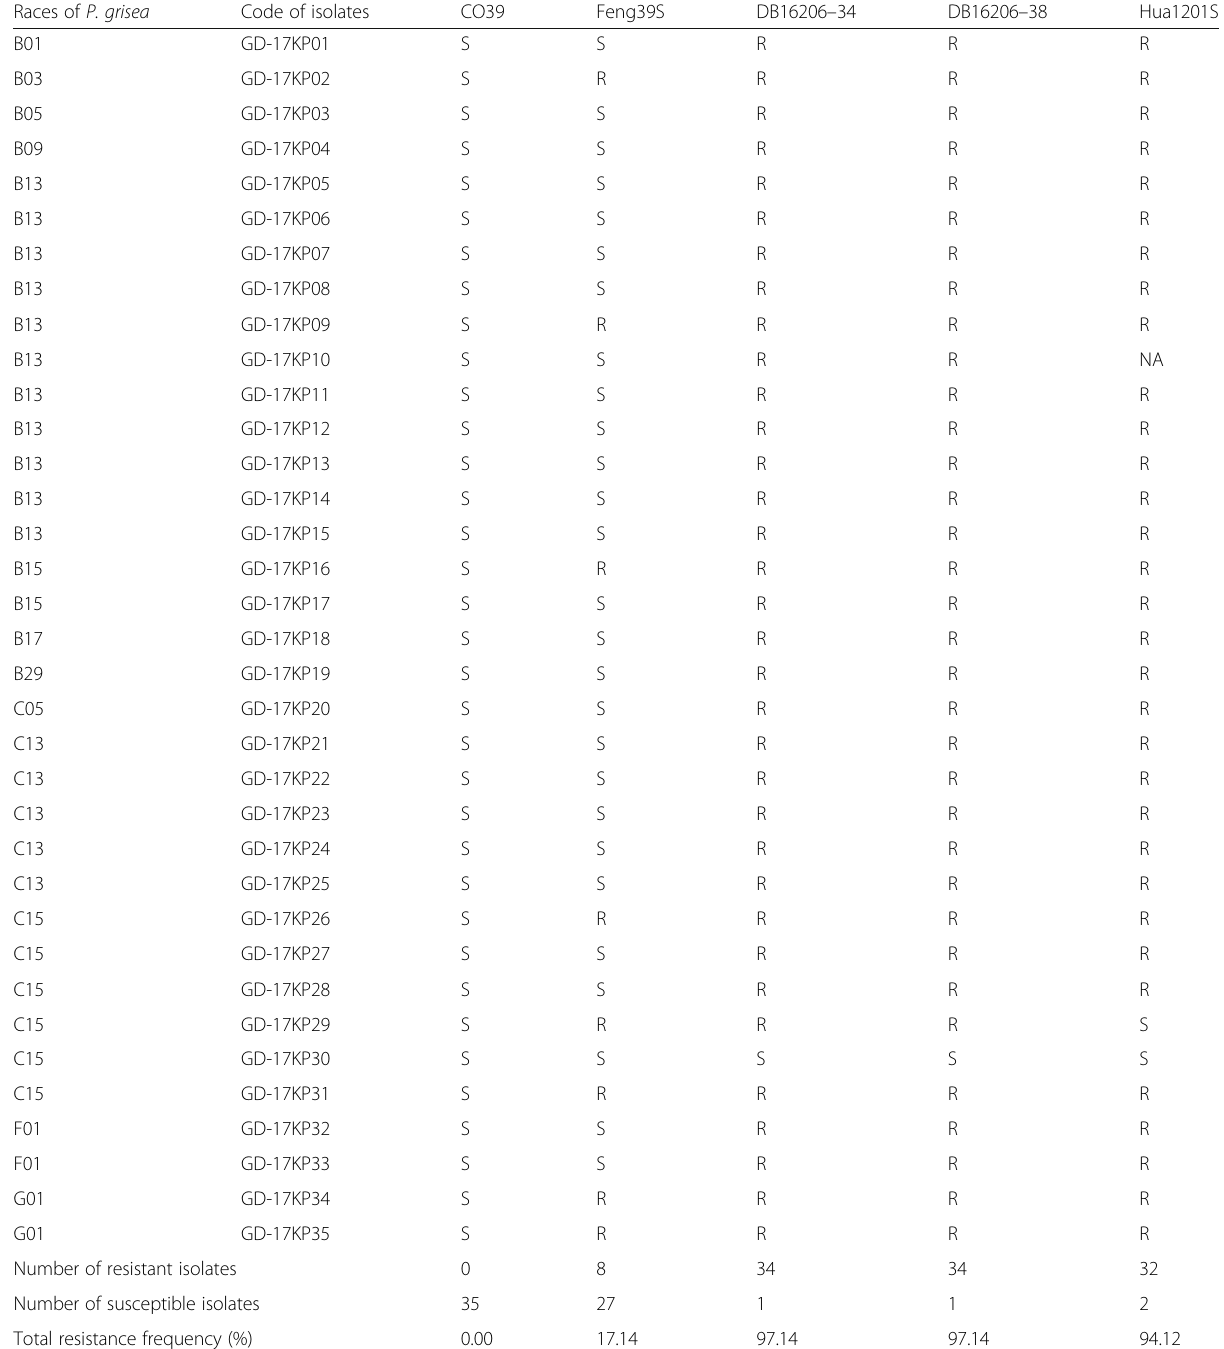
Table 1 Disease resistance reaction at seedling stage of breeding lines, susceptible check (CO39), and parents to 35 rice blast isolates under artificial inoculation in the greenhouse in 2017 Races of P.